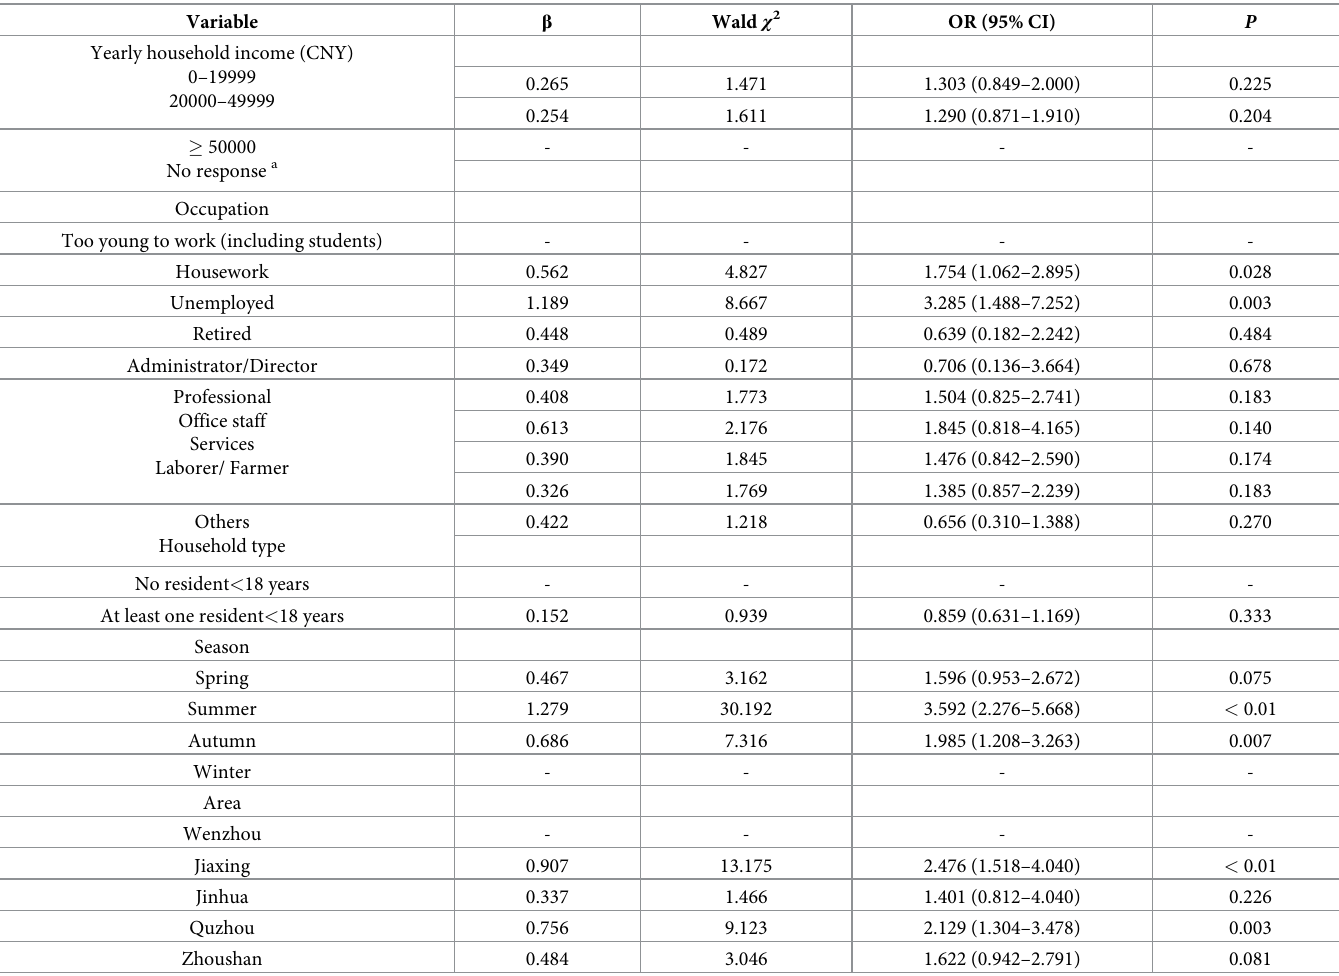
Table 3. Multivariable analysis of yearly household income, occupation, household type, season, area and AGI prevalence in the 4 weeks prior to interview in Zhe- jiang Province, July 2018-June 2019.